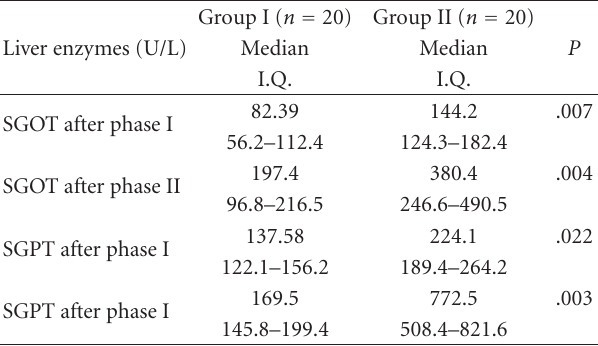
Table 2: Toxic hepatitis in both leukemia groups during phases I and II of chemotherapy.